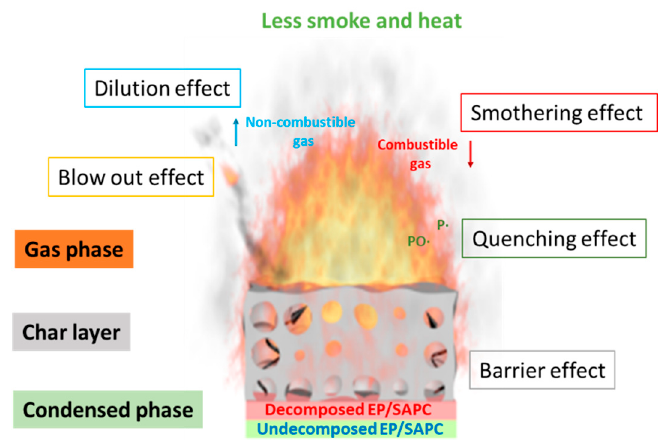
Scheme 4. Flame retardant mechanism for the EP / SAPC composites.